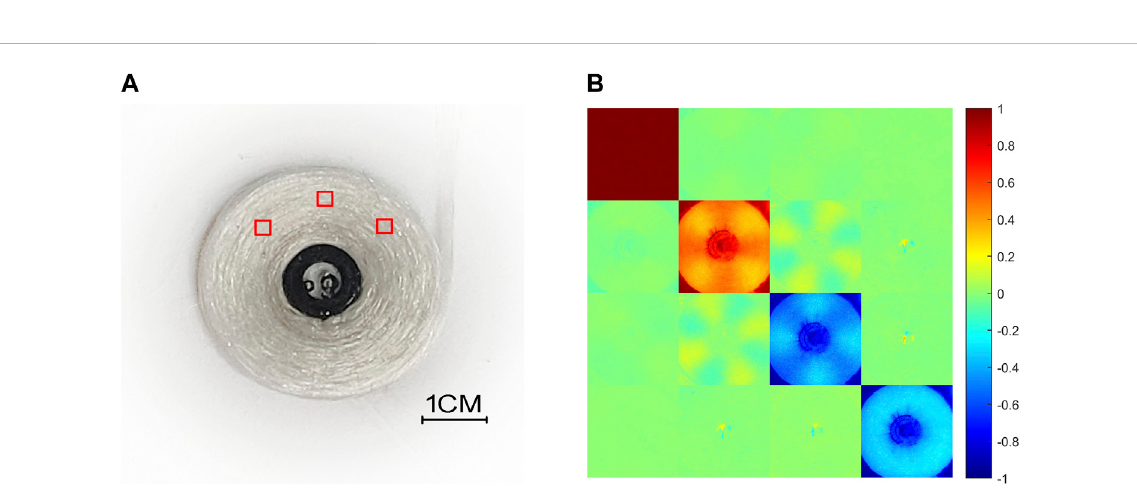
FIGURE 5 A well-aligned silk sample (A) and its Mueller matrix image (B) .